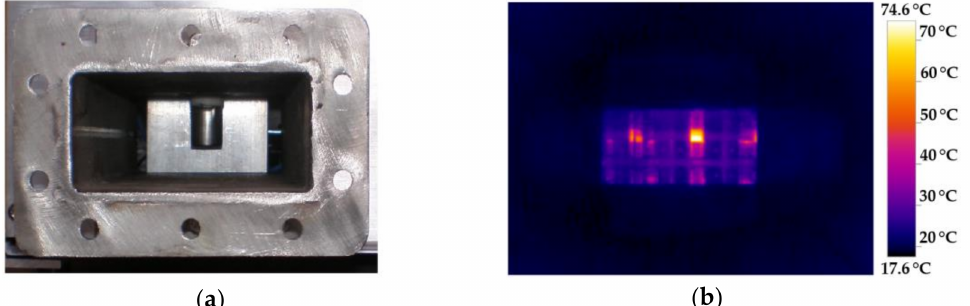
Figure 9. Display of a typed R32 waveguide: ( a ) mounting the magnetron antenna in the R32 waveguide; ( b ) display of waveguide temperature after 10 min of full power.